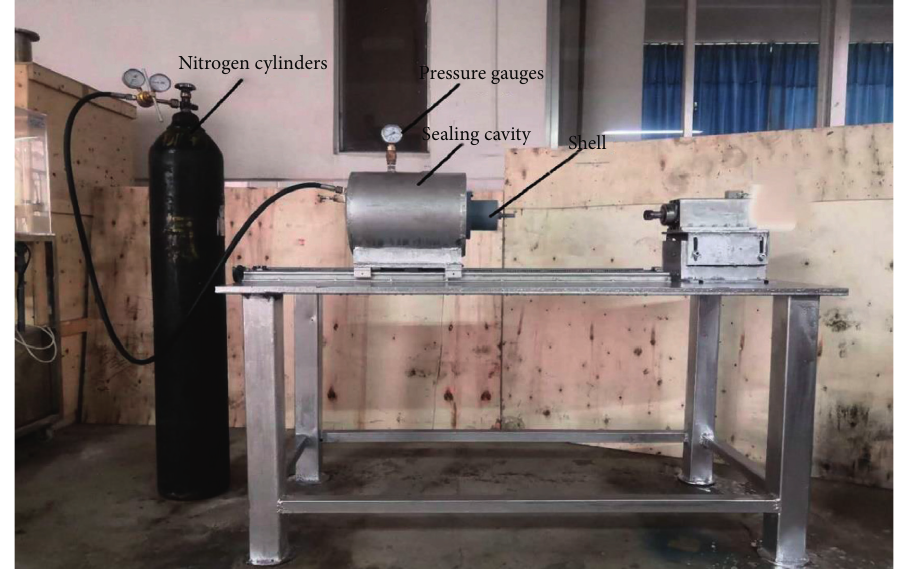
Figure 10: Test bench of magnetic fluid